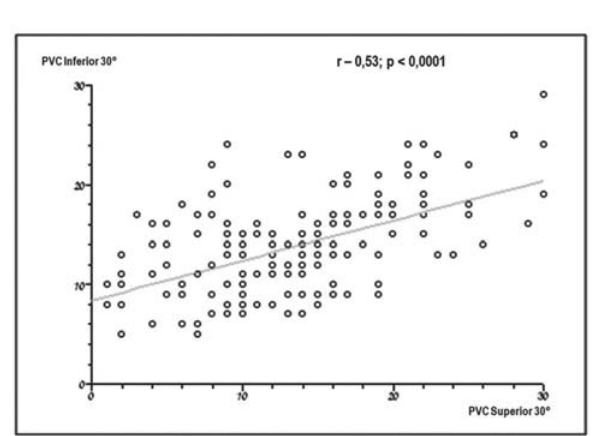
Fig. 2 - Correlação linear entre PVC em sítio inferior e superior a trinta graus. Gráfico mostrando correlação linear positiva entre as medidas de PVC em inclinação de 30 graus da cabeceira do leito